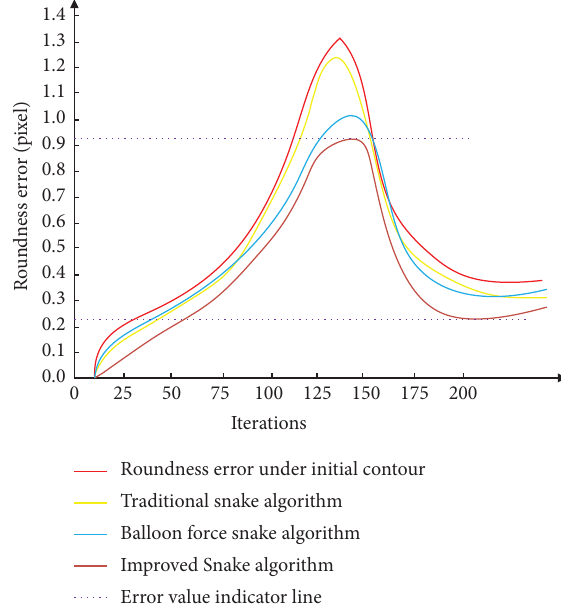
Figure 9: Comparison of flter rod roundness error detection under diferent